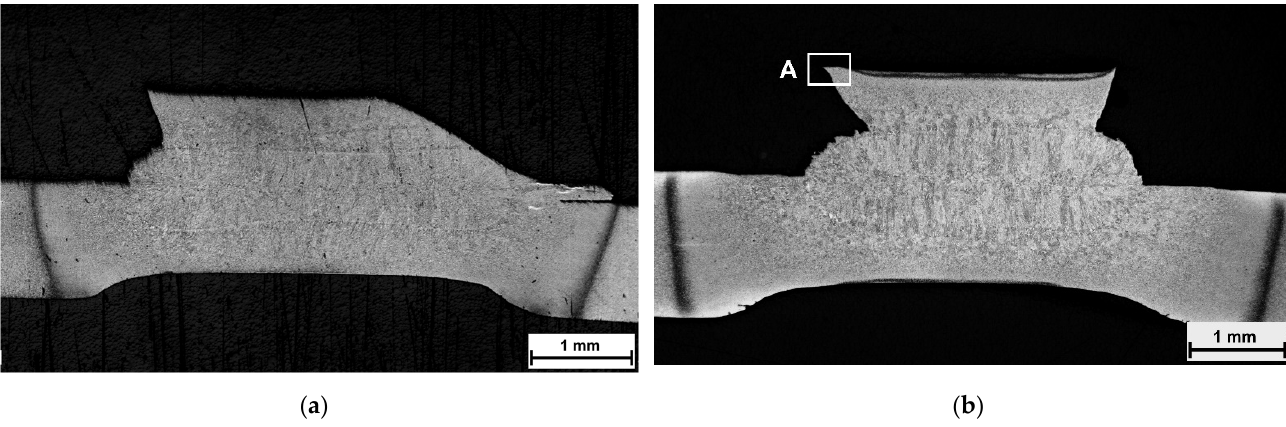
Figure 8. Cross-sections of welded and fractured martensitic steel showing the fracture morphology of the pull-out fracture: uncoated ( a ) and Zn-coated sample with a marked area, A, of SEM-EDS analysis ( b ).